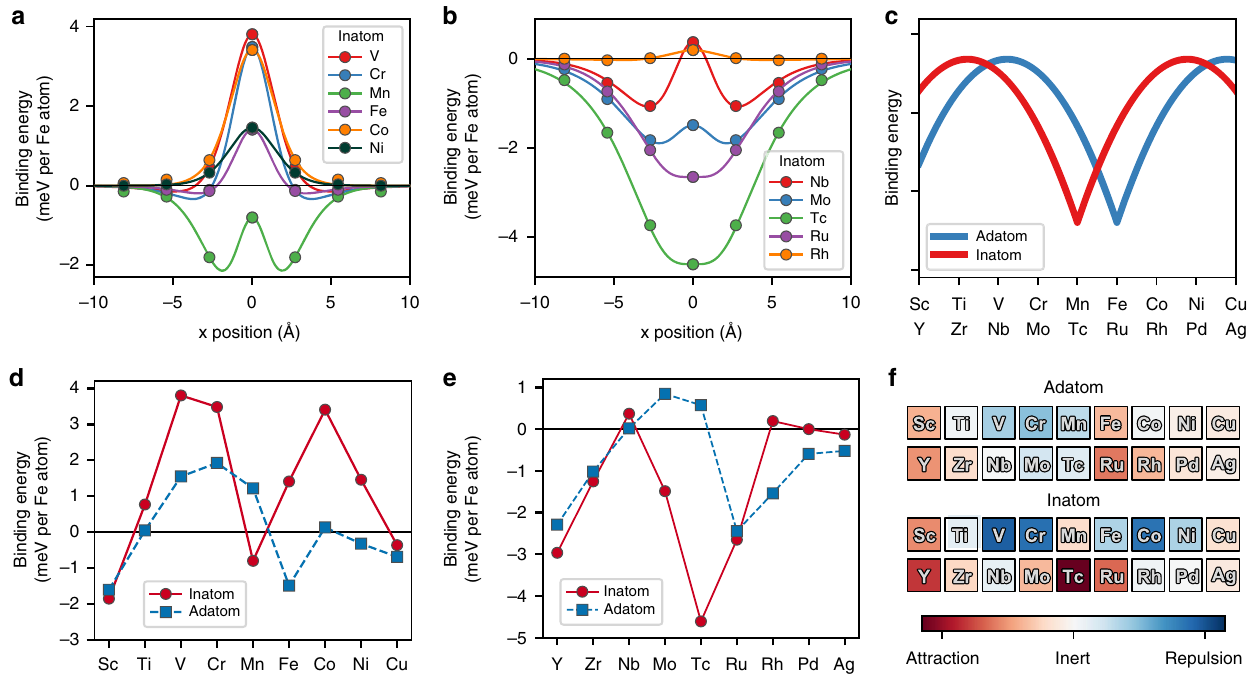
Fig. 2 Skyrmion-defect binding energies. a , b Binding energies as function of the x position of the inatoms with respect to the skyrmion core as de fi ned in Fig. 1. A negative (positive) binding-energy indicates an attractive (repulsive) skyrmion-defect interaction. The discrete ab initio results (circles) are interpolated with lines resulting from fi ts to Morse potentials. c Schematic illustration of the M-shape behavior for the interaction pro fi le with a two-peak feature close to the edges of the transition metal series and a minimum around half- fi lling, i.e., in the middle of the series. d , e Impact of band- fi lling on the binding energies considering inatom (solid) and adatom (dashed) impurities located close to the skyrmion center. f Periodic table for inatom and adatom defects with the color scale indicating the strength of their binding energies. Red corresponds to attraction and blue to splitting. In the collinear con fi guration, the minority-spin virtual bound state (VBS) is unoccupied (Fig. 3a, red curve) and weakly